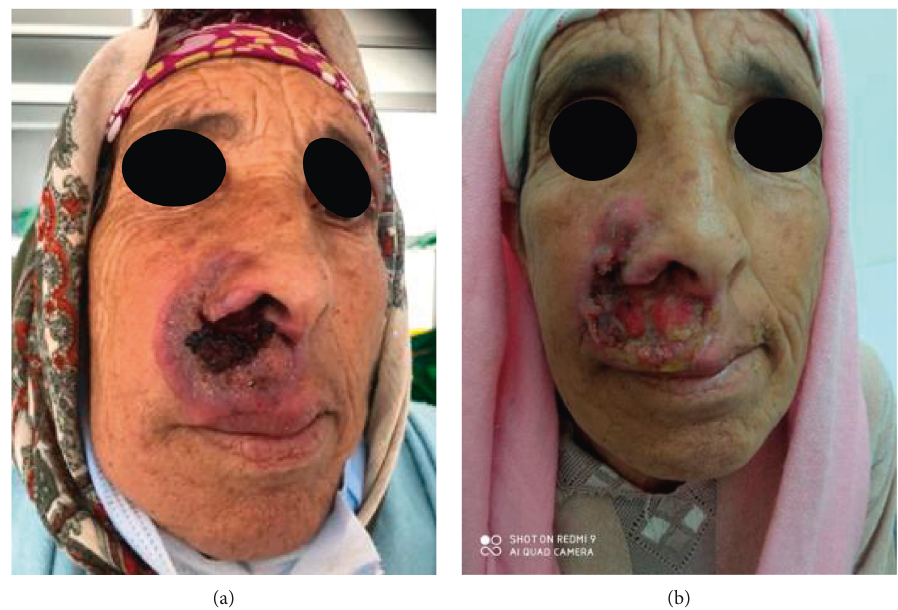
Figure 1: (a) Ulcerated and necrotic right nasolabial plaque with destruction of the right nasal wing on day 1 of the consultation. (b) Ulcerated and necrotic nasolabial plaque with significant loss of substance one month later after the first day of consultation.